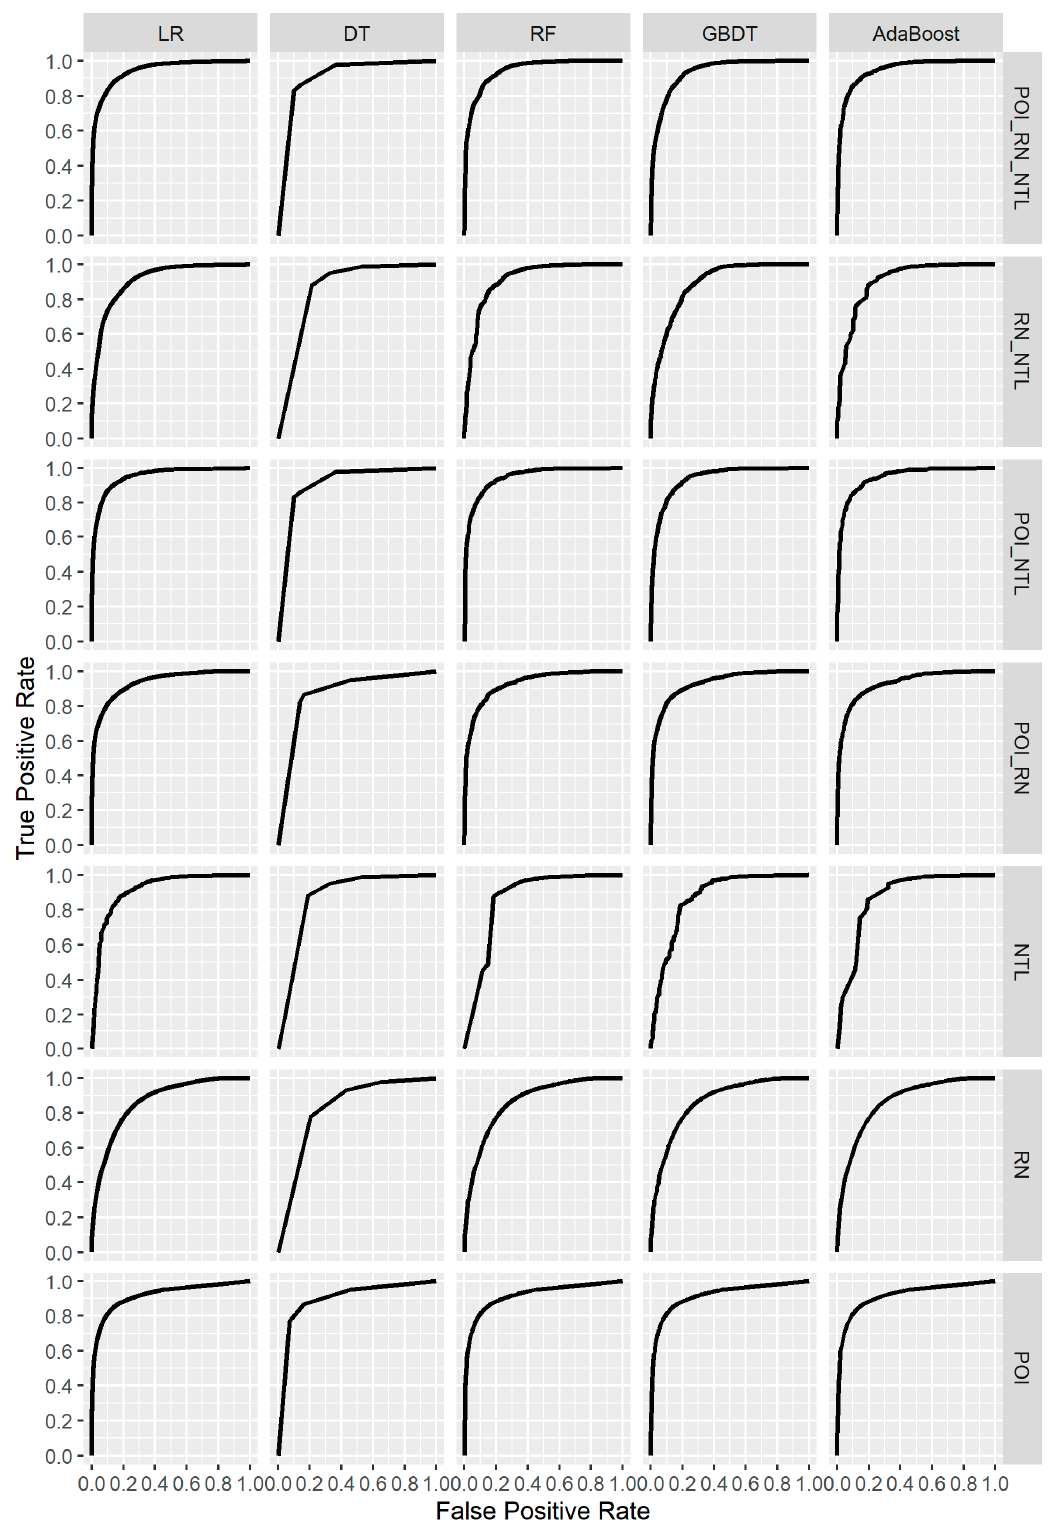
Figure 11. Receiver operating characteristic (ROC) curves of 35 combinations between the five classifiers and seven types of input data using the BAIC.